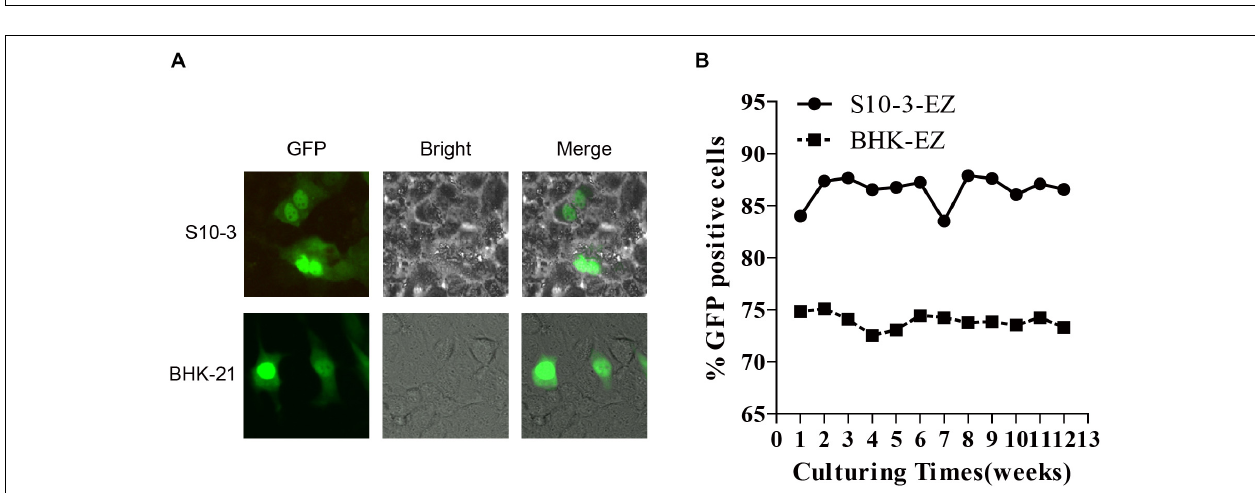
FIGURE 2 | Detection of ORF1 expression in two HEV replicon cell lines. (A) Western blot analysis confirming EGFP and ORF1 protein expression in S10-3-EZ and BHK-EZ cells. (B) Cell lines were stained with anti-HEV ORF1 X domain monoclonal antibody to confirm ORF1 expression by IFA.